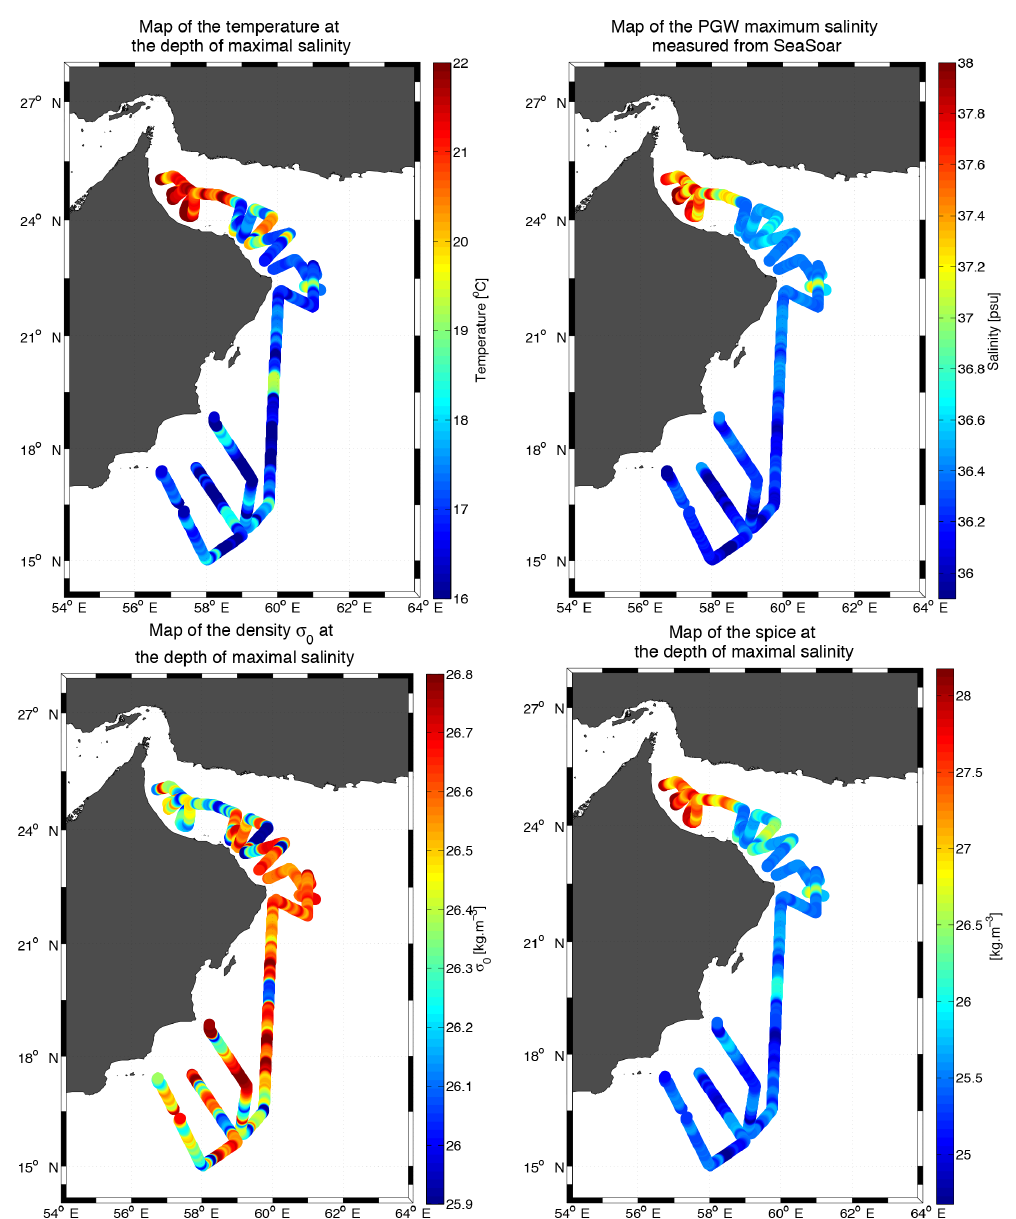
Figure 12. Maximal thermohaline characteristics of the Persian Gulf Water (from the SeaSoar measurements, for σ 0 between 26 and 26.7). The variables are temperature (top, left), salinity (top, right), σ 0 at the maximal salinity depth (bottom, left), and spice at the same depth (bottom,